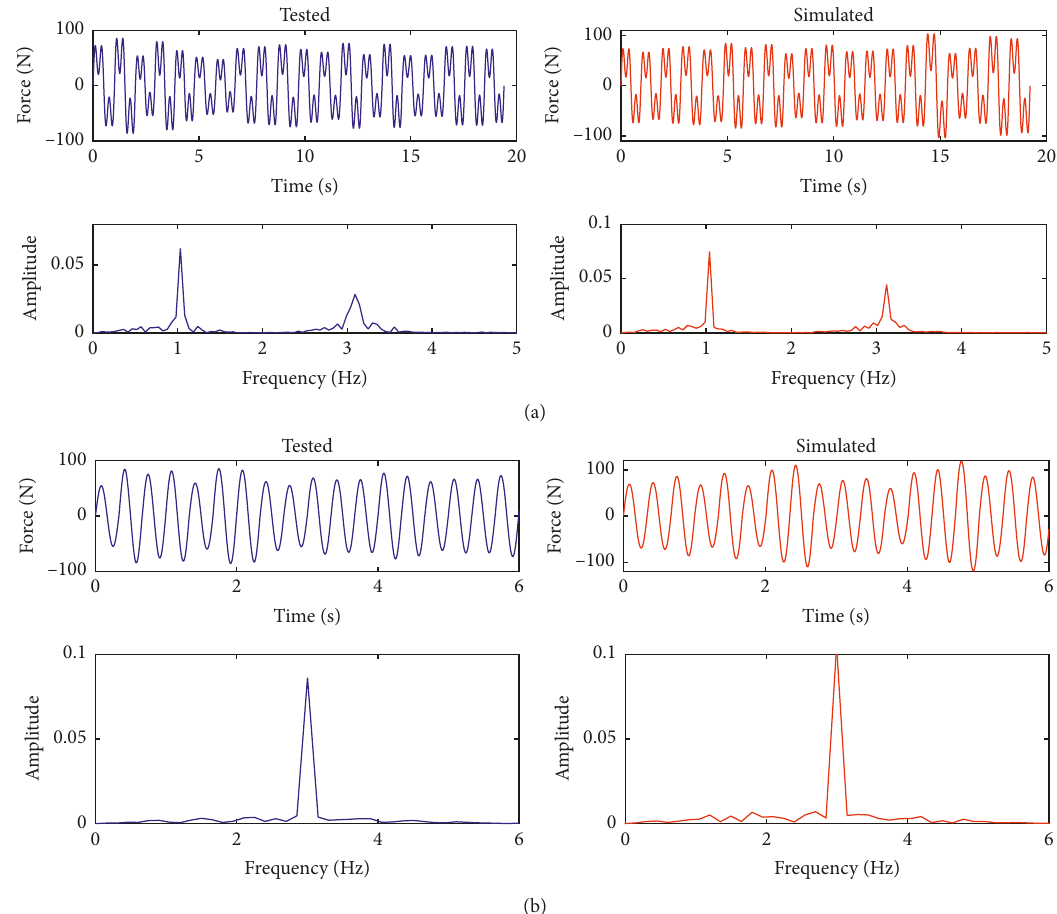
Figure 6: Compared measures with simulated force signals at time and frequency domain. (a) The results of swaying frequency 1.0Hz and (b) the results of swaying frequency 3.0Hz.